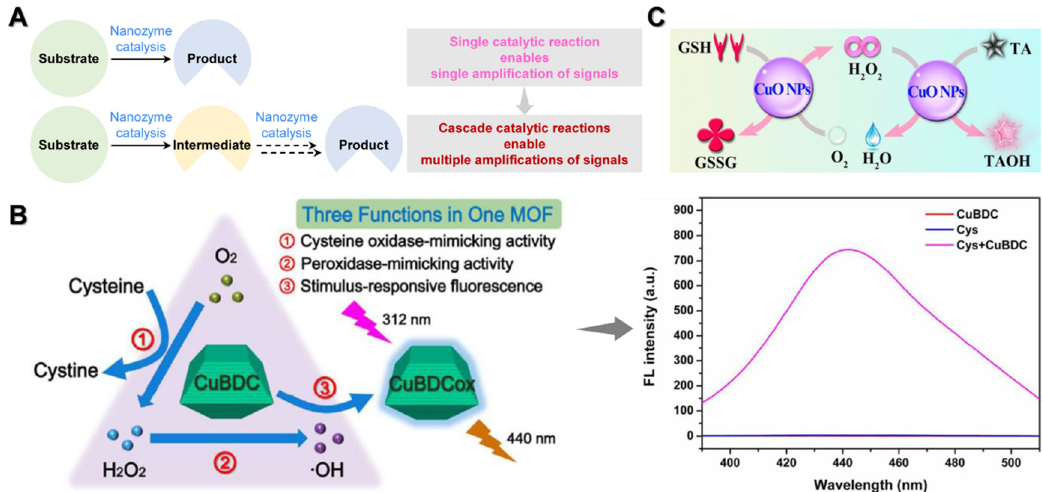
Figure 3. ( A ) Comparison of nanozyme-involved cascade catalytic reactions with a single reaction for highly-sensitive sensing. ( B ) Design of CuBDC with cascade cysteine oxidase- and peroxidase-mimicking activities for cysteine detection (reprinted with permission from Ref. [63]). ( C ) Self-cascade system based on CuO NPs with GSH oxidase- and peroxidase-like activities (reprinted with permission from Ref. [64]).